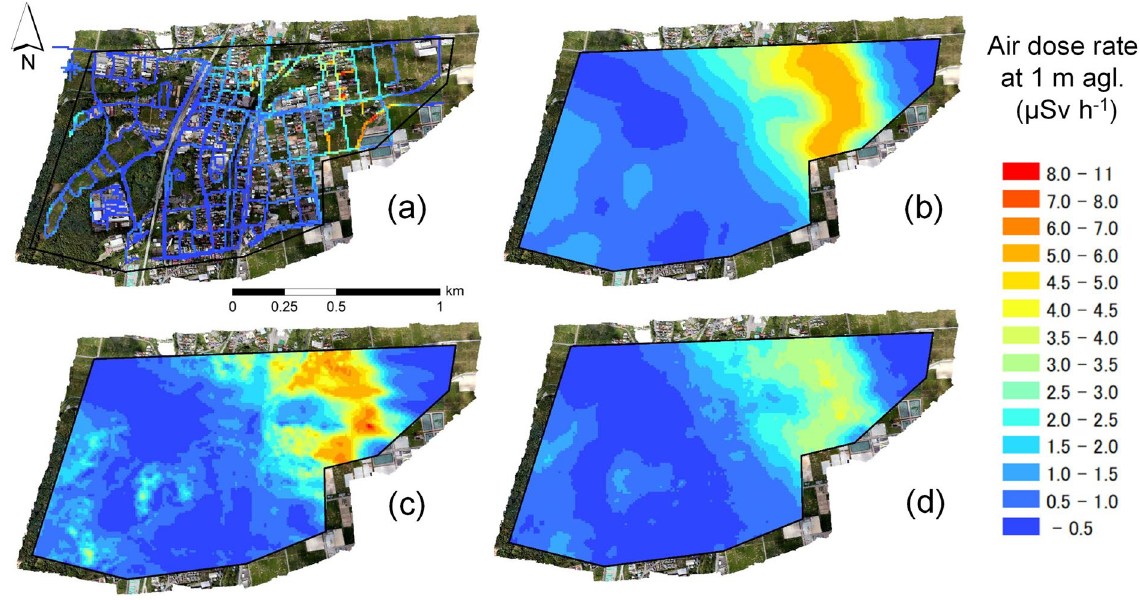
Figure 7. Air dose rate maps at 1 m agl. by ( a ) ground-based survey, ( b ) UAV-survey using the FSM, ( c ) UAV- survey using the ML-EM, and ( d ) UAV-survey using the ANN. This map was created using ArcGIS 10.5. https :// www.esri.com/ja-jp/arcgi s/about -arcgi s/overv